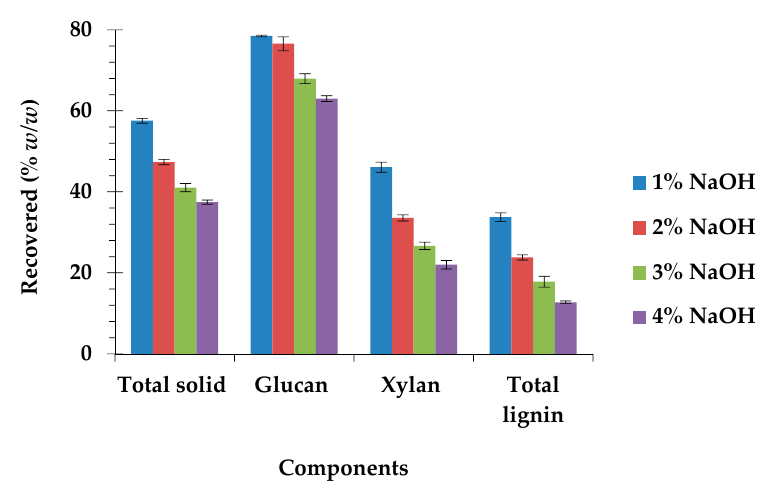
Figure 1. Effect of NaOH concentrations on the chemical composition of Chloris barbata .